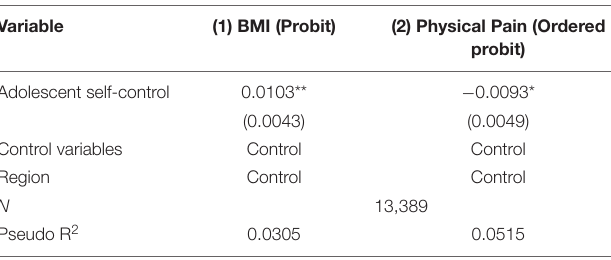
TABLE 5 | Effects of adolescent self-control on body mass index and physical pain in